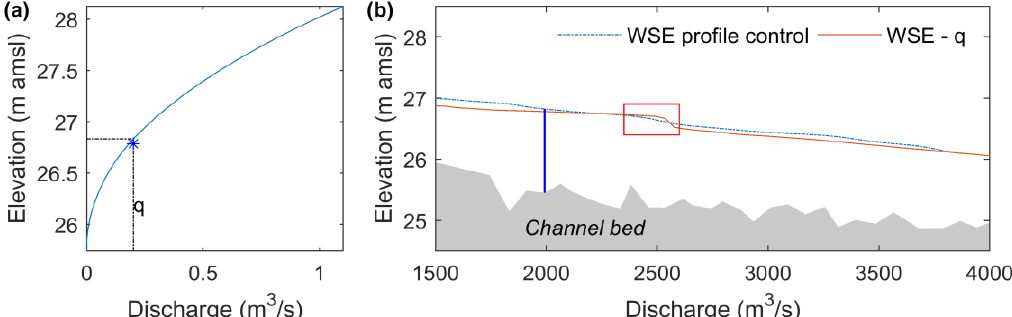
Figure 9. Illustration of curve control and profile control. ( a ) Requirement curve at one control station. ( b ) Reach-scale WSE profile control (dash-dot) and a synthetic WSE profile for a given discharge, e.g., q in (a). The blue bar indicates the location of the control station shown in (a). Red rectangle highlights the position where the WSE does not meet the requirement WSE profile.